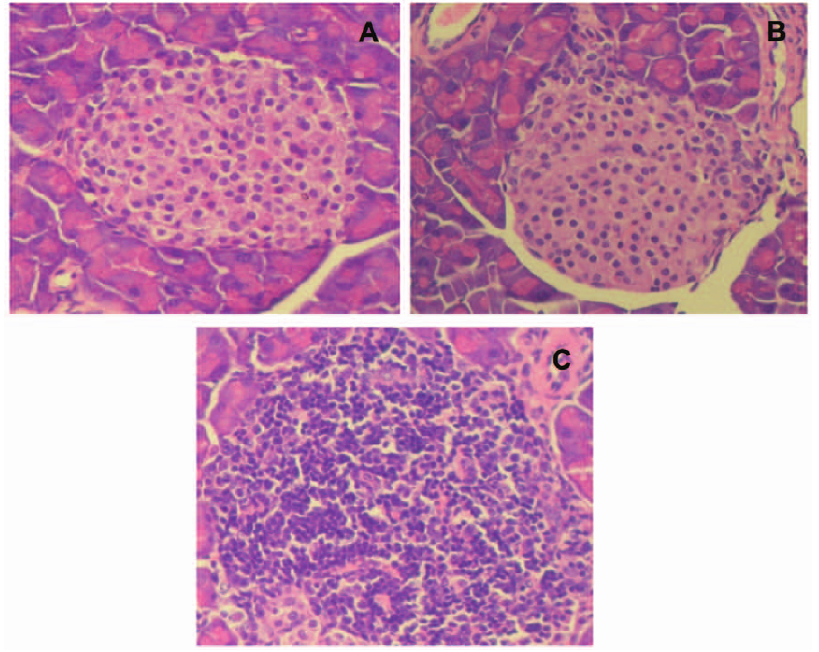
Figure 5. The histopathology of pancreatic islets at onset of diabetes or at 40 weeks of age. Representative images of pancreatic islets from animals injected with 50 m g (A) and 100 m g (B) MAb 8E6G4 IgG, or control animals (C). Pancreatic tissues were sectioned and stained with hematoxylin and eosin. doi:10.1371/journal.pone.0032515.g005 PLoS ONE |